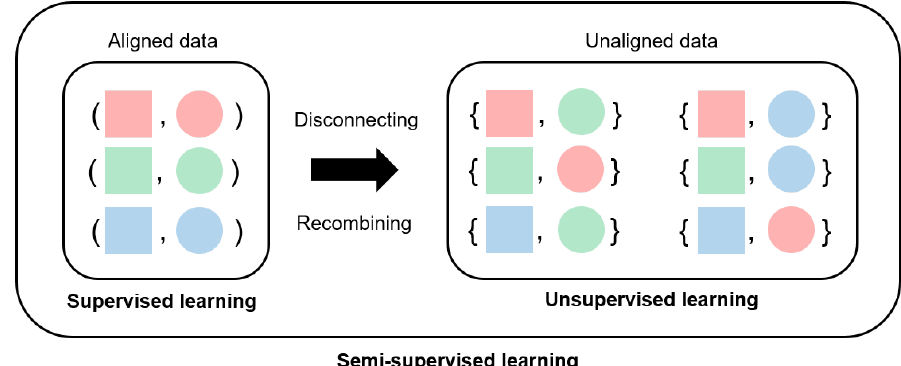
Figure 1. Illustration of the conversion of supervised learning to semi-supervised